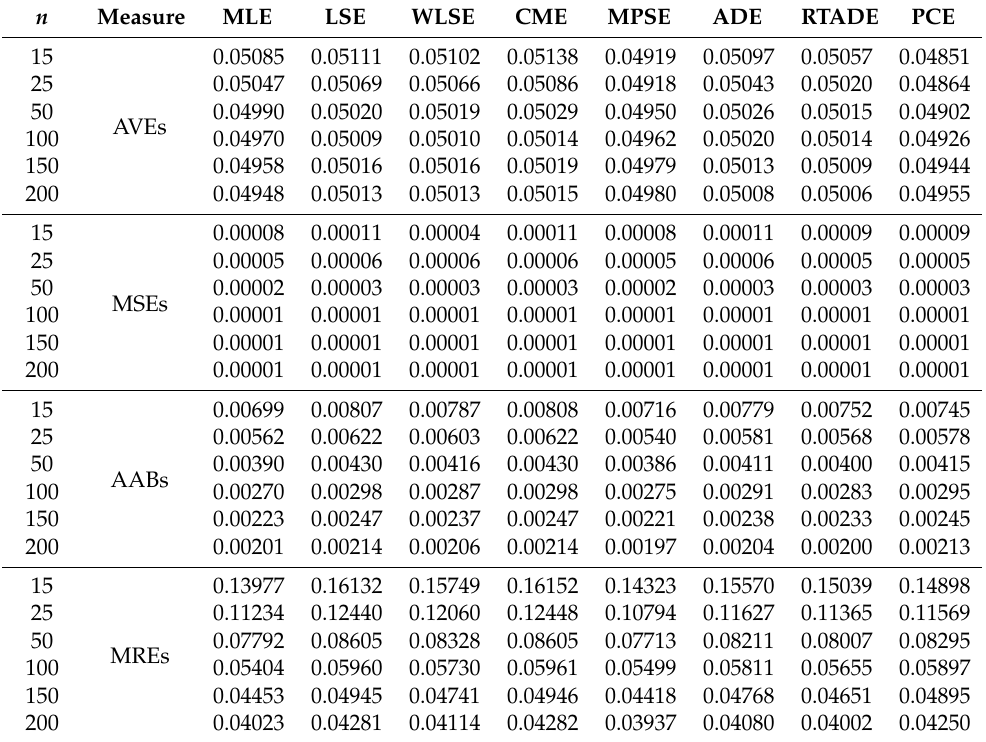
Table 1. Simulation results for the NDL distribution for θ = 0.05.